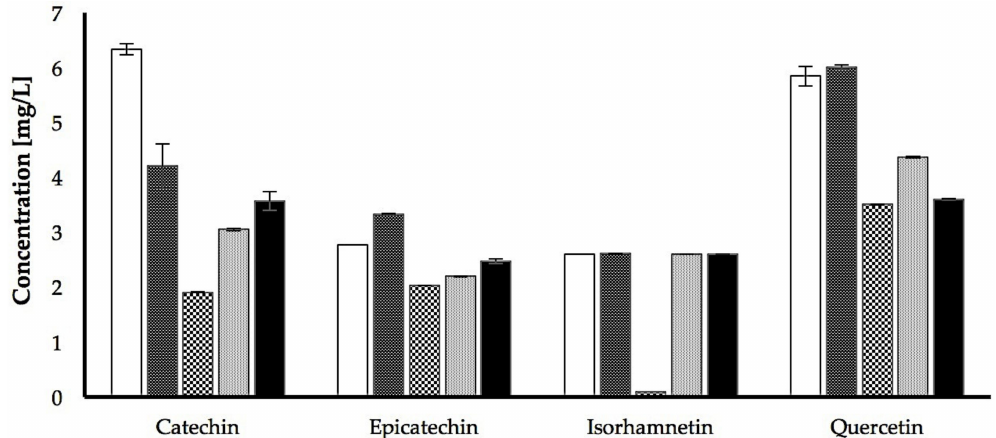
Figure 1. Concentrations of the flavonoids identified in the grape juice of Vitis vinifera varietals Airen ( ), Gewürztraminer ( ), Sauvignon blanc ( ), Verdejo ( ), and Tempranillo ( ). Esculetin was the only polyphenol quantified from the phenylpropanoid family.